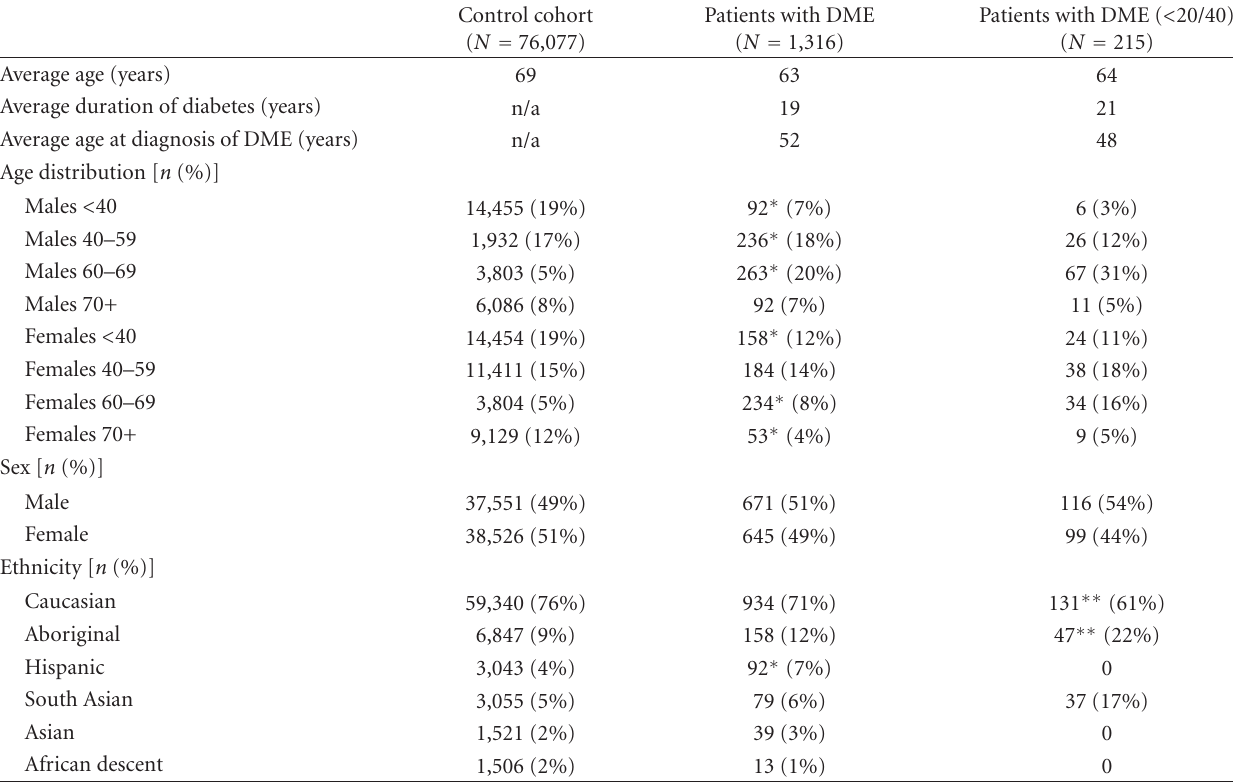
Table 1: Demographics of the populations